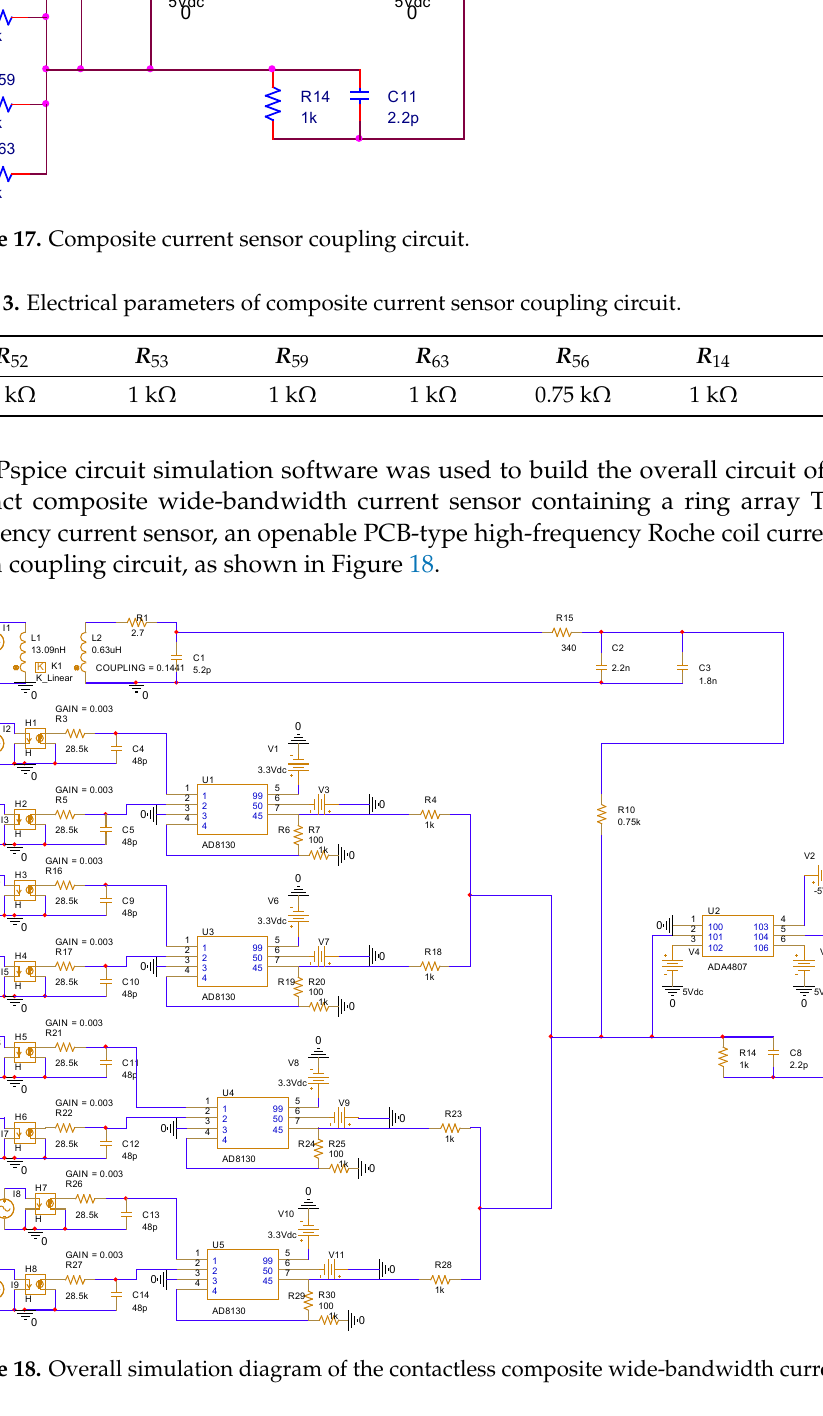
Figure 18. Overall simulation diagram of the contactless composite wide-bandwidth current sen- sor.